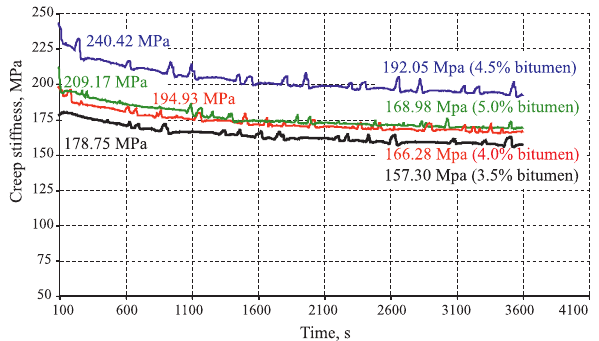
Fig. 9. Average creep stiffness versus time graphs for optimum- optimal polypropylene modified